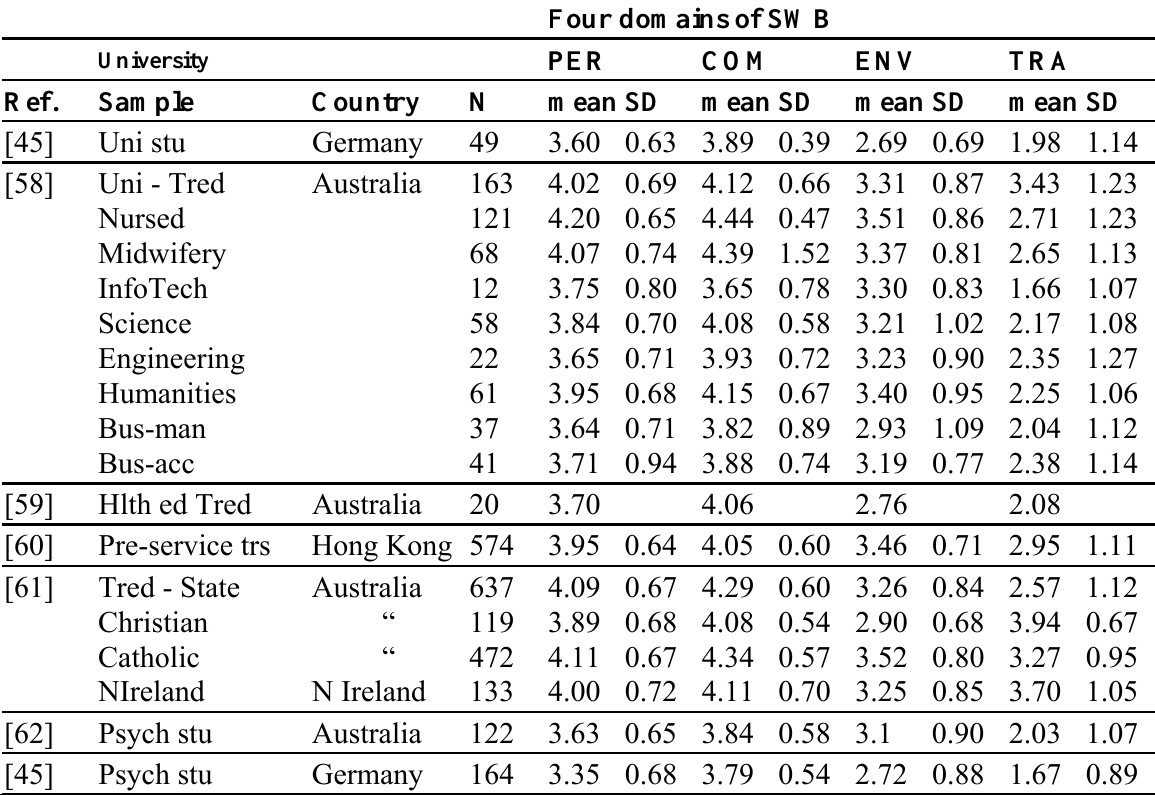
Table 3. SWB levels among university students using the